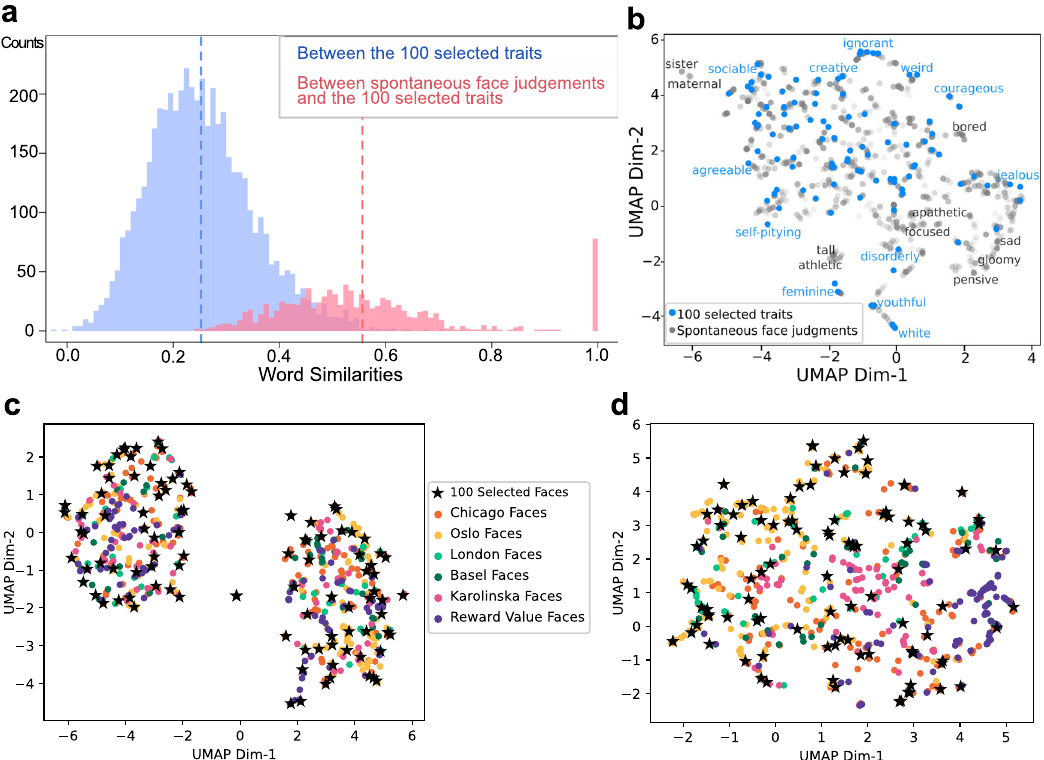
Fig. 2 Representativeness of the sampled traits a – b and face images c – d. a Distributions of word similarities. The similarity between two words was assessed with the cosine distance between the 300-feature vectors 70 of the two words. The blue histogram plots the pairwise similarities among the 100 sampled traits. The red histogram plots the similarities between each of the freely generated words during spontaneous face attributions ( n = 973, see Supplementary Fig. 1a) and its closest counterpart in the sampled 100 traits. Dashed lines indicate means. All freely generated words were found to be similar to at least one of the sampled traits (all similarities greater than the mean similarity among the sampled traits [except for the words “ moving ” and “ round ” ]). Eighty- fi ve freely generated words were identical to those in the 100 sampled traits. b Uniform Manifold Approximation and Projection of words (UMAP 75 , a dimensionality reduction technique that generalizes to nonlinearities). Blue dots indicate the 100 sampled traits (examples labeled in blue) and gray dots indicate the freely generated words during spontaneous face attributions (see Methods; nonoverlapping examples labeled in gray, which were mostly momentary mental states rather than temporally stable traits). c UMAP of the fi nal sampled 100 faces (stars) compared with a larger set of frontal, neutral, white faces from various databases 76 – 78 (dots, N = 632; see also Supplementary Fig. 1b for comparison with faces in real-world contexts). Each face was represented with 128 facial features as extracted by a state-of-the-art deep neural network 74 . d UMAP of the fi nal sampled 100 faces (stars) compared with the larger set of faces (dots) as in c . Each face was represented here with 30 automatically measured simple facial metrics 72 (e.g., pupillary distance, eye size, nose length, cheekbone prominence). Source data are provided as a Source Data fi